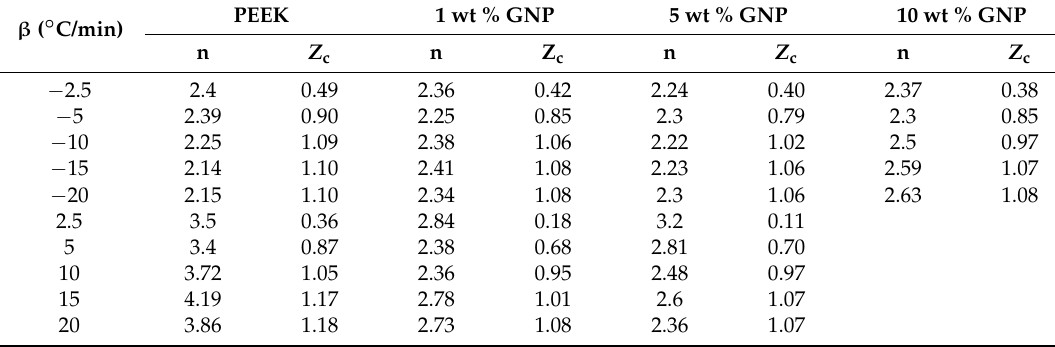
Table 2. Calculated n and Z c values at different cooling (negative rates) and heating rates (positive rates), calculated from the slopes and intercepts of the linear parts of the modified Avrami plots. PEEK β ( ◦ C/min) −